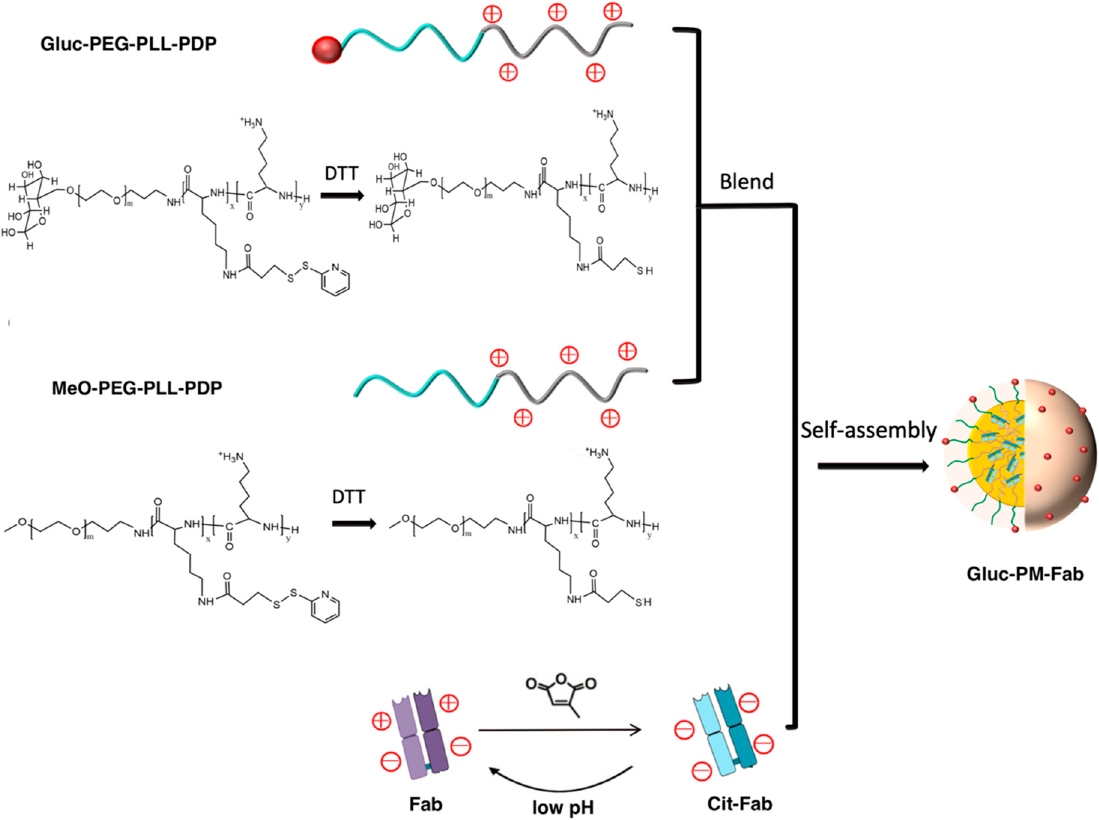
Figure 6. Graphical representation of the design of a dual pH–redox-sensitive, Fab-encapsulated, glucosylated polymeric nanomicelle (Gluc-PM-Fab) development via the assembly of negatively charged Cit-Fab and the positively charged block copolymers. Reprinted with permission from [81].